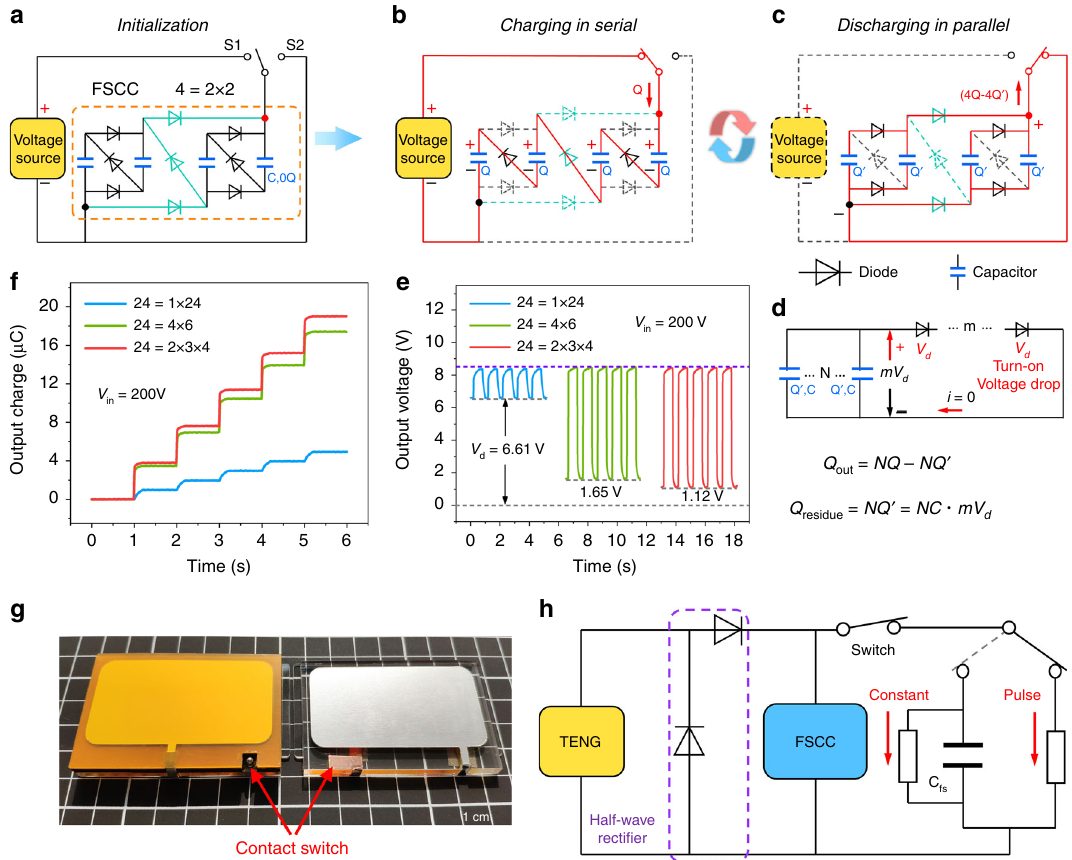
Fig. 2 The principle of FSCC power management system. a Initialization state of 4 = 2 × 2 FSCC system. b , c The step-down process during a charging/ discharging cycle. The FSCC can achieve multifold charge output through the auto-switch of capacitors from serial to parallel connection. d The equivalent diagram of discharging process of FSCC in c . The turn-on voltage drop of diode has a signi fi cant in fl uence on charge output. e The output voltage and f the output charge of 24-unit FSCC with different orders. 1st order FSCC has the largest turn-on voltage drop and the output charge increases rapidly with multi-order FSCC. g Photograph of triboelectric nanogenerator (TENG) with a contact switch in this work. h Schematic diagram of the power management system, which consists of a TENG, half-recti fi er circuit, contact switch and FSCC, and there are two output modes in pulse and constant after power